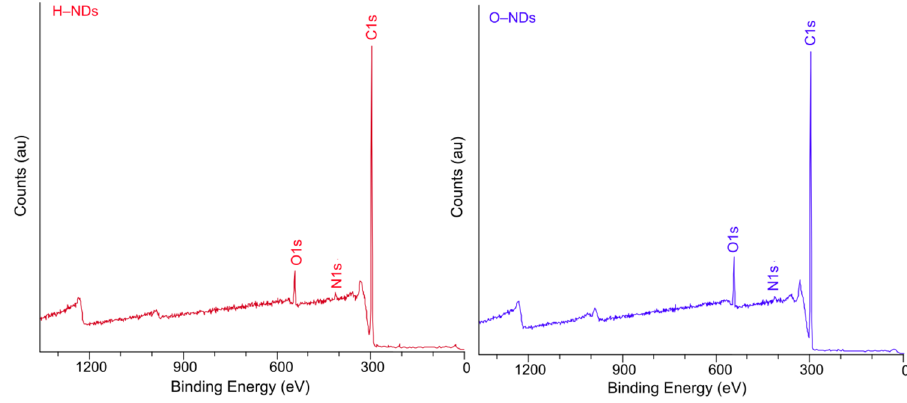
Figure 2. XPS spectra for ( a ) H–NDs and ( b ) O–NDs. Highlighted peaks are the C1s, O1s and